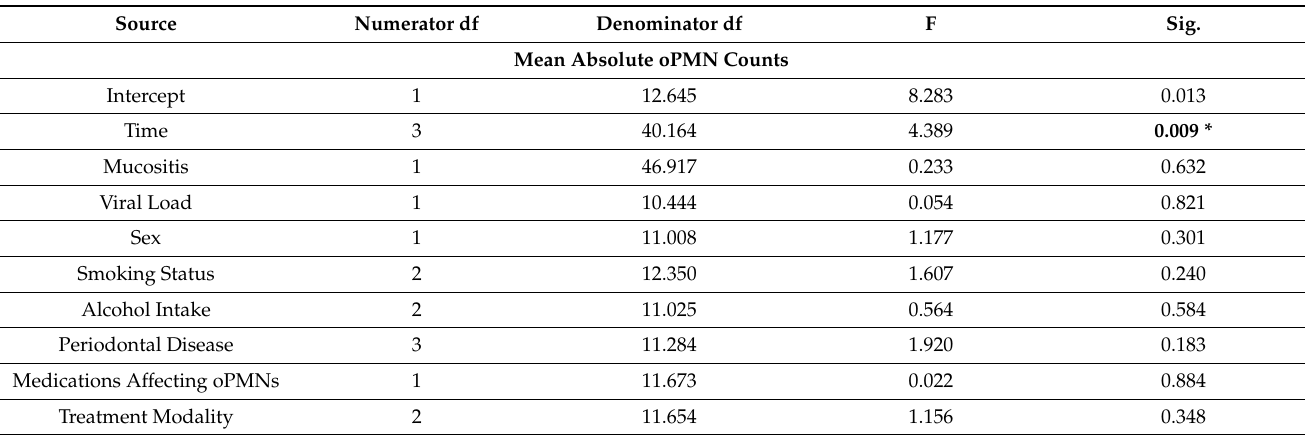
Table A2. Results of the LMM analysis adjusting for covariates on the mean oPMN absolute counts across the four time points.